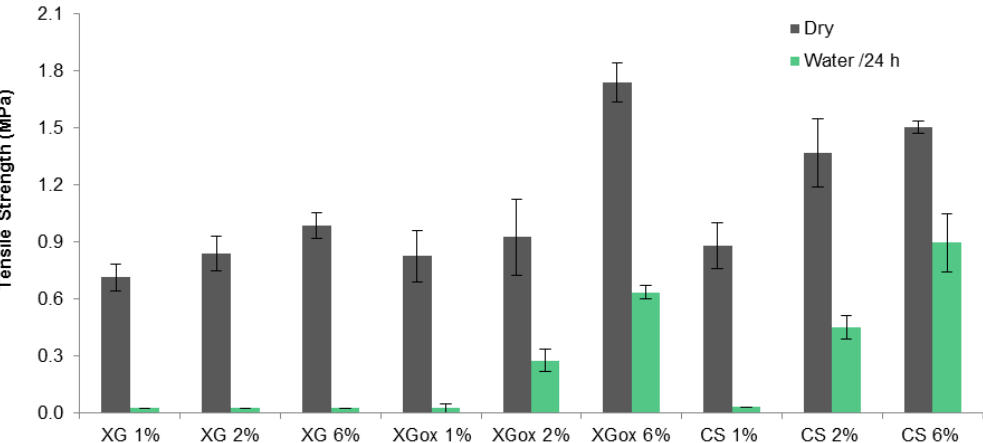
Figure 5. Tensile strength and water resistance of cork joints glued with xanthan gum, oxidized xanthan gum, and chitosan adhesives for different concentrations. Error bars represent standard deviations for a minimum of five measurements.